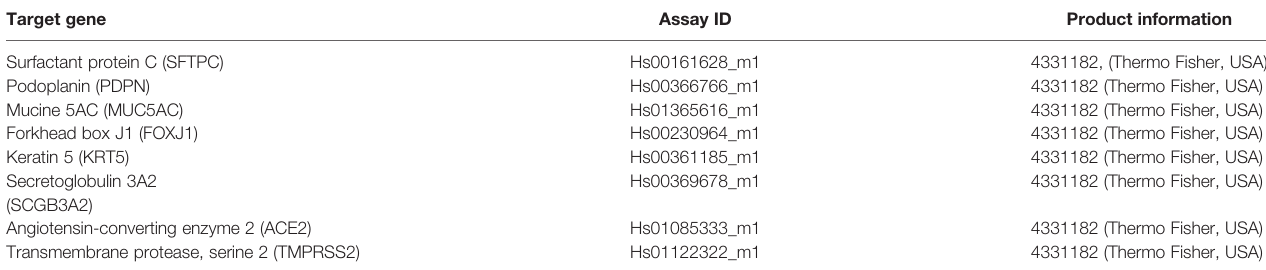
TABLE 2 | Product information for TaqMan probes used in RT-qPCR